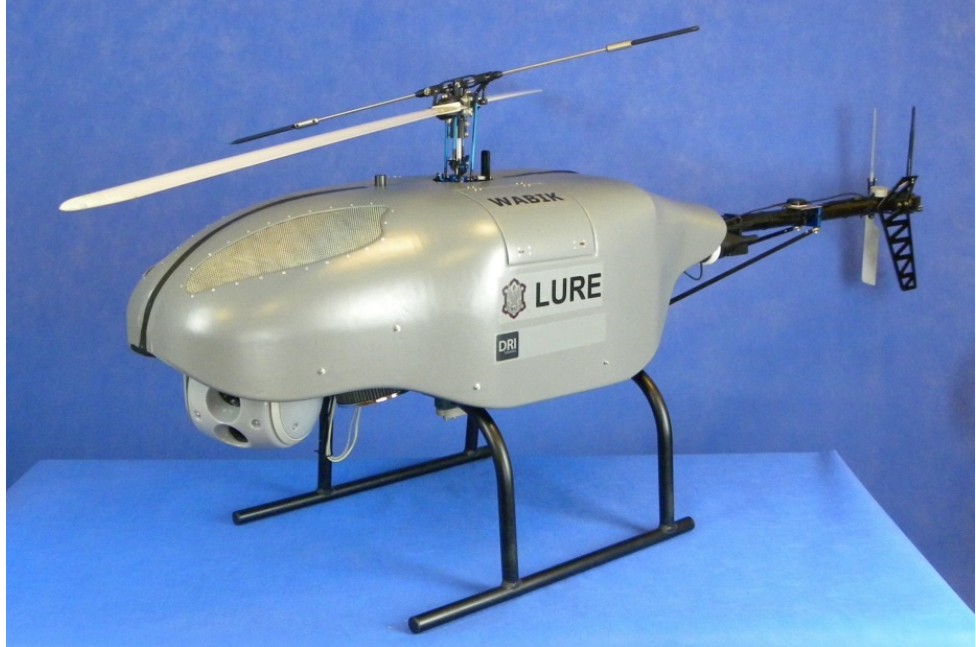
Figure 1. Unmanned aerial vehicle (UAV) WABIK.